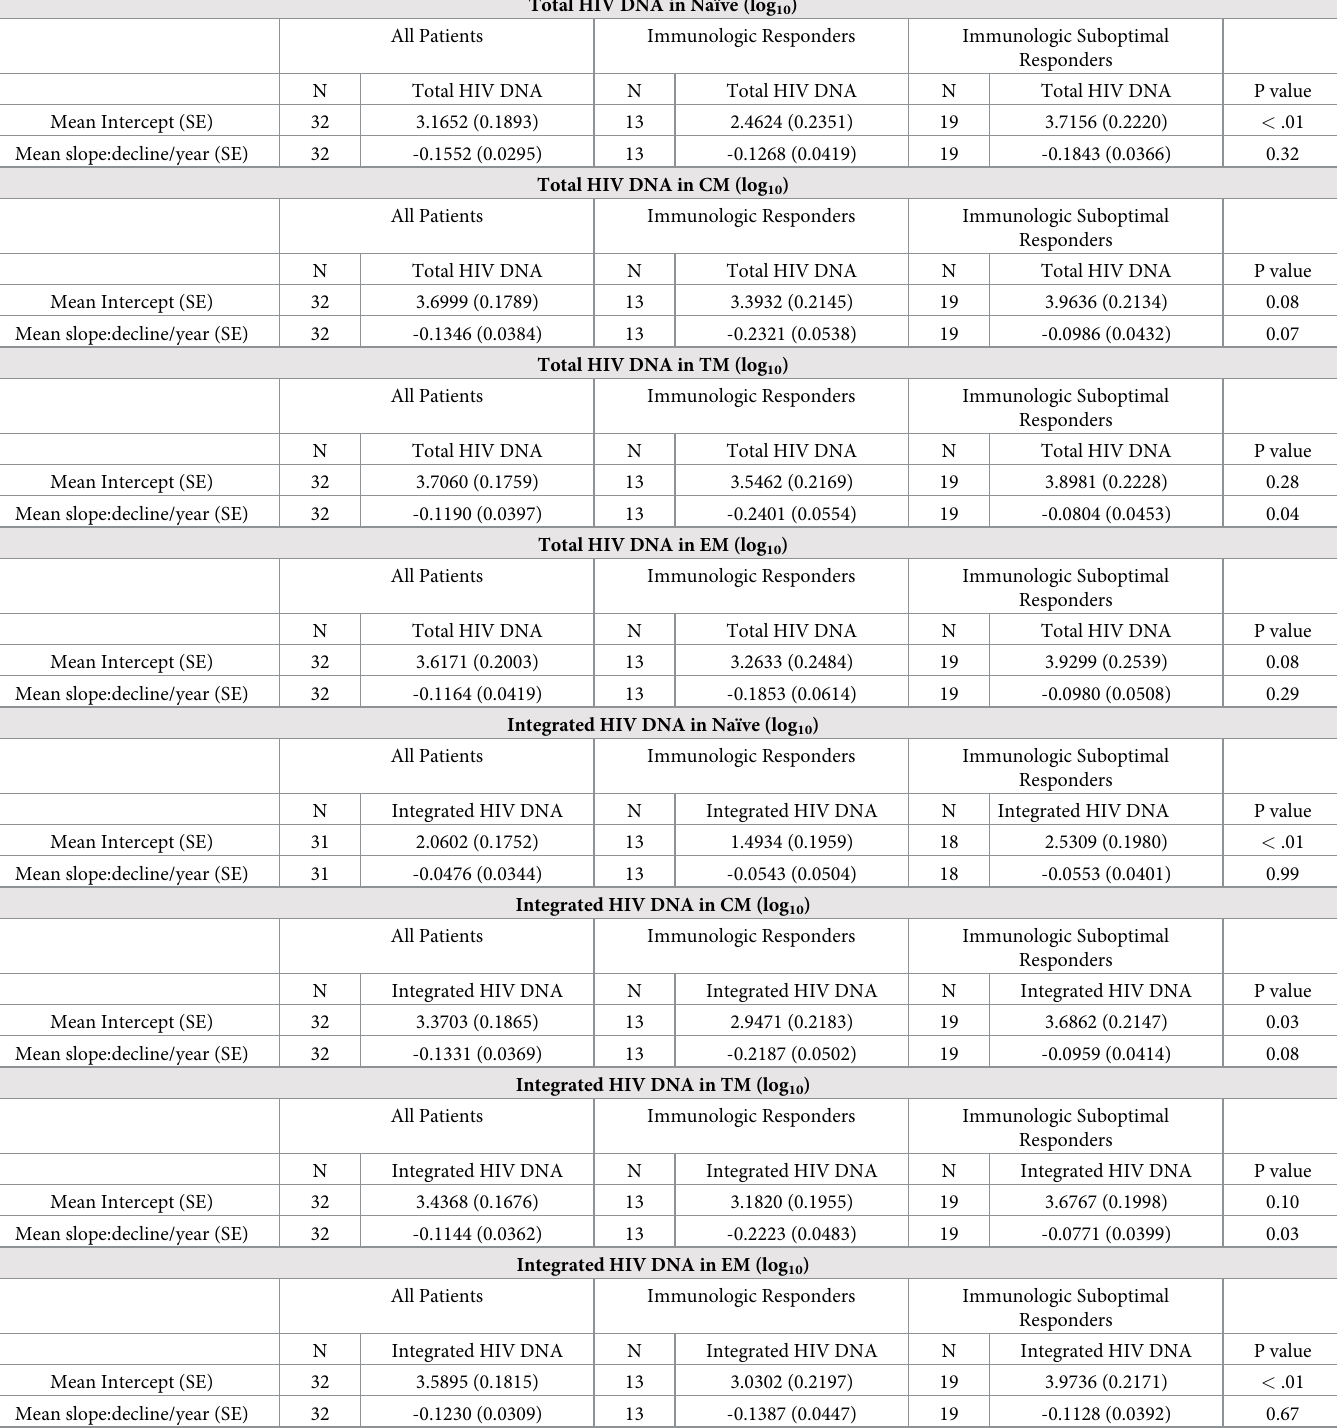
Table 2. Mean total and integrated HIV-DNA decay in CM, TM, EM, and na ï ve T-cells (log transformed) slope:decline/year and